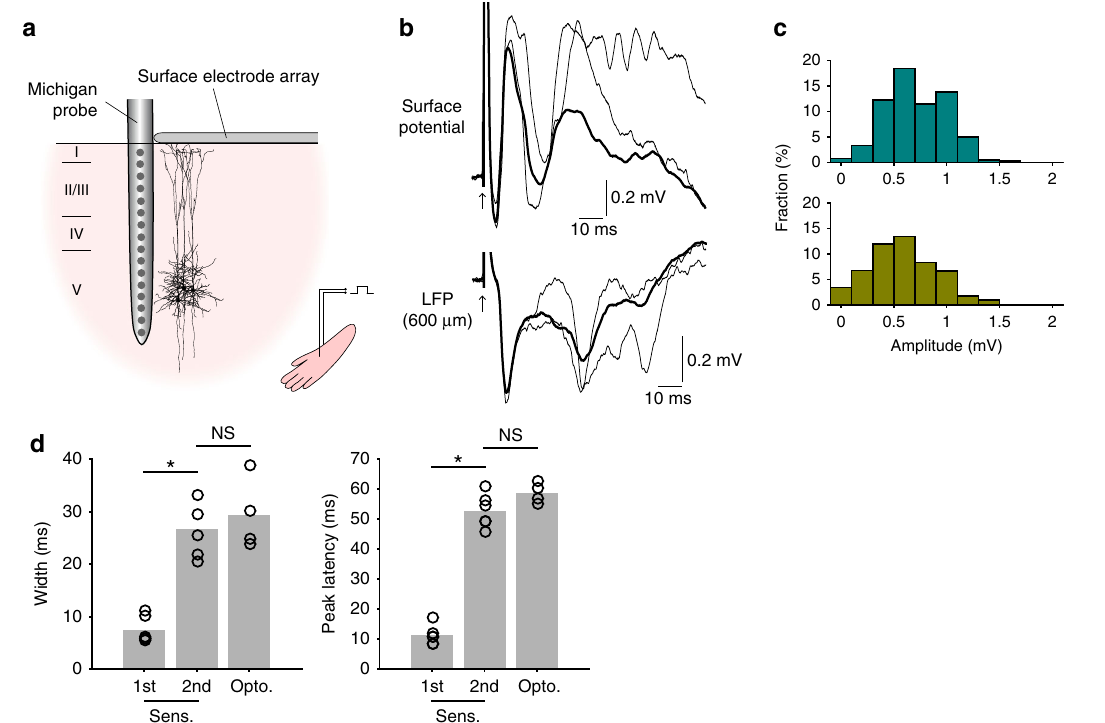
Fig. 6 Sensory-evoked dendritic Ca 2+ spikes also greatly affect surface potentials. a Schematic diagram of apparatus for recording sensory-evoked surface potentials. b Surface potentials aligned with LFPs recorded at 600 μ m below the pia. Thick lines denote the average over 10 measurements; thin lines show representative traces where the late sink is as large as the fi rst. c Surface positive potentials evoked by the fi rst sink ( top ) and those evoked by the late sink ( bottom ). Pooled data from all rats ( n = 6). d Width and peak latency of the fi rst and second spikes evoked by sensory stimulus, compared